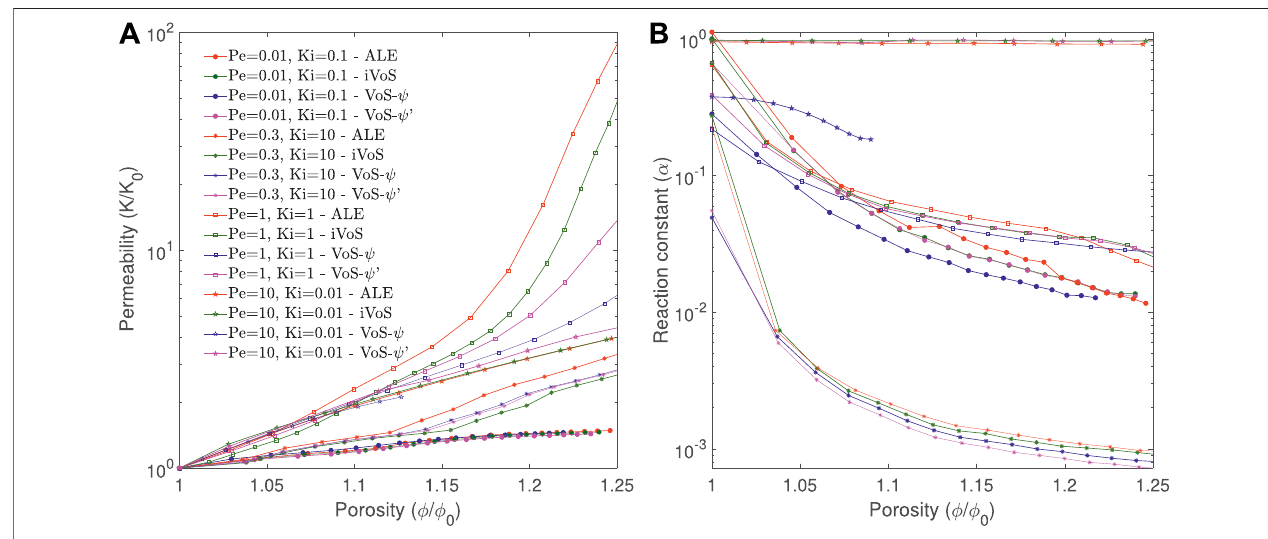
FIGURE7| Evolutionofthepermeabilityand macro-scalereaction constantduringnumericalsimulationofdissolutionin a2D micromodel atfour different regimes obtained with the ALE, the (A) VoS- ψ and the (B) iVoS methods.